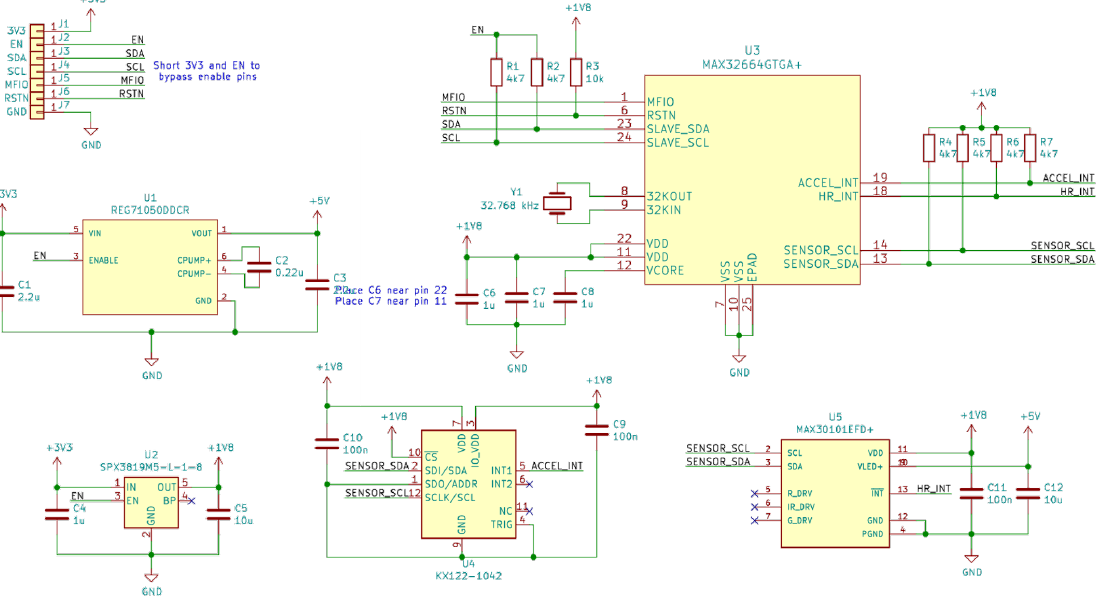
Figure 6. Circuit diagram for the SpO2 and HR monitoring subsystem. This figure has been generated with KiCAD (https://www.kicad.org, accessed on 14 June 2022). The names in green are the names of the Integrated Circuits. In red are the pin numbers of the